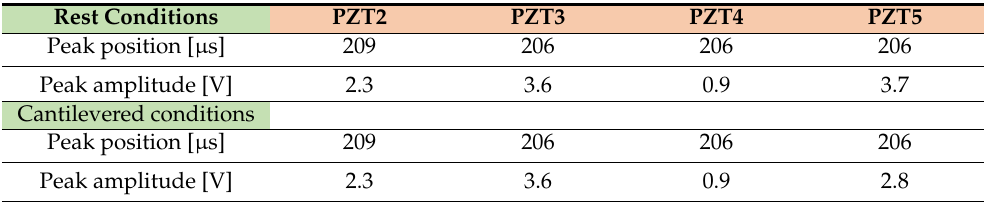
Table 3. Main parameters of the Lamb wave detected by the PZTs.